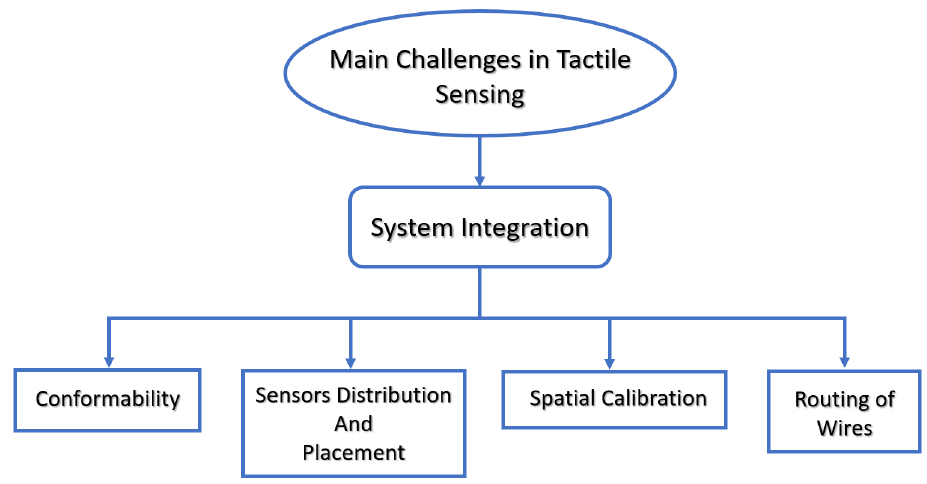
Figure 2. The main challenges in tactile sensing addressed with the inkjet printing